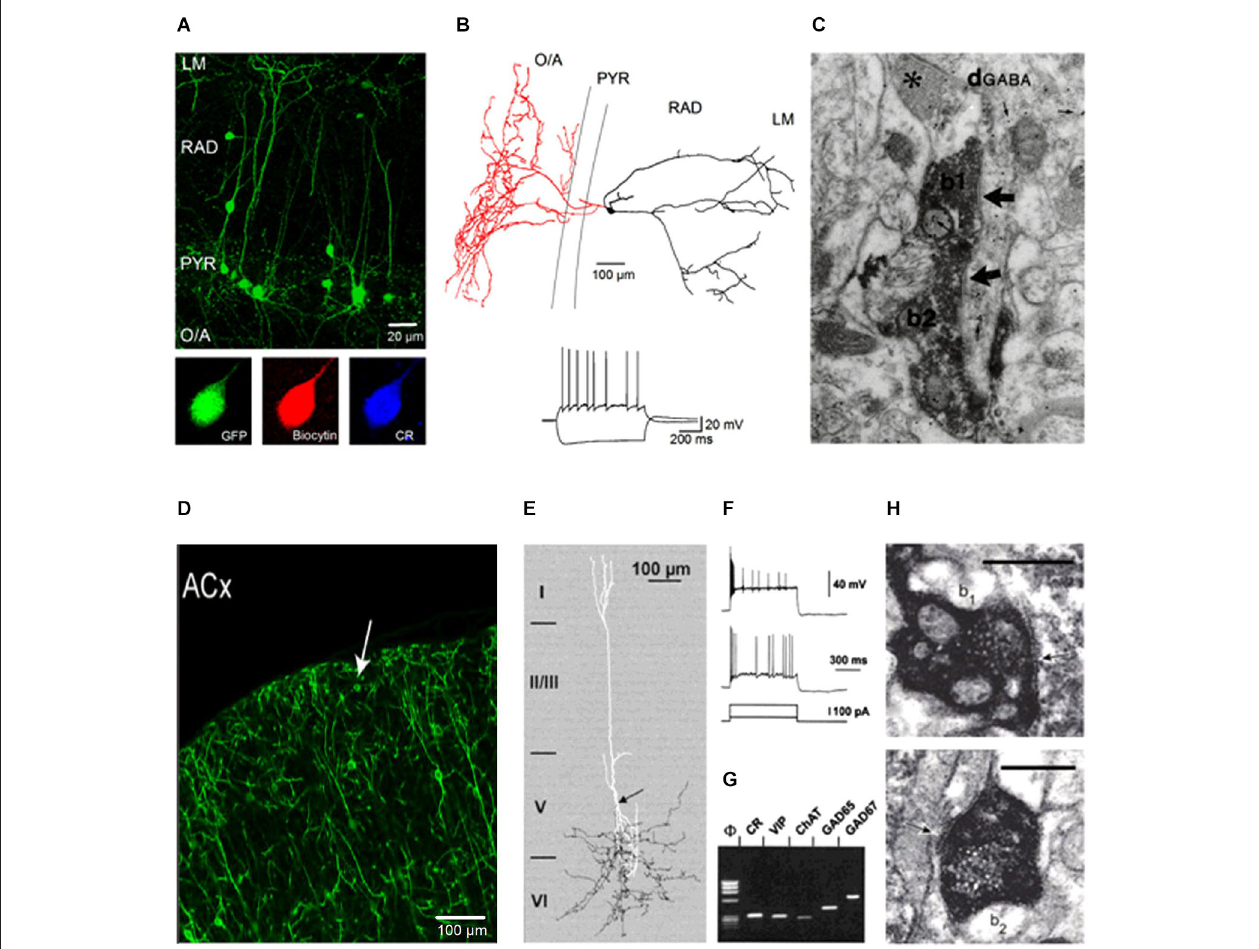
features and layer distribution of VIP+ somata; arrow indicates a VIP+ interneuron in the first layer. Scale bar, 100 µ m (Data are from Pi et al., 2013). (E) Anatomical reconstruction of a VIP+ interneuron with dendrites shown in white and axon shown in black. The arrow indicates the initiation point of a descending axon arborizing in the sixth cortical layer (Data are from Porter et al., 1998). (F,G) Electrophysiological and molecular properties of CR/VIP coexpressing interneurons in the neocortex. (F) Voltage responses to depolarizing pulses of 50 (lower trace) and 200 (upper trace) pA. The response consists of an initial burst followed by intermittent action potentials at an irregular frequency. (G) Single-cell RT-mPCR analysis showing the expression of ChAT, GAD65 and GAD67 mRNAs in CR/VIP coexpressing neocortical interneurons (Data are from Porter et al., 1998). (H) EM images of symmetric synapses (indicated by arrows) formed by VIP- presynaptic boutons (b 1 and b 2 ) with the soma of CB+ interneuron. Scale bars, 0.5 µ m (Data are from Staiger et al.,